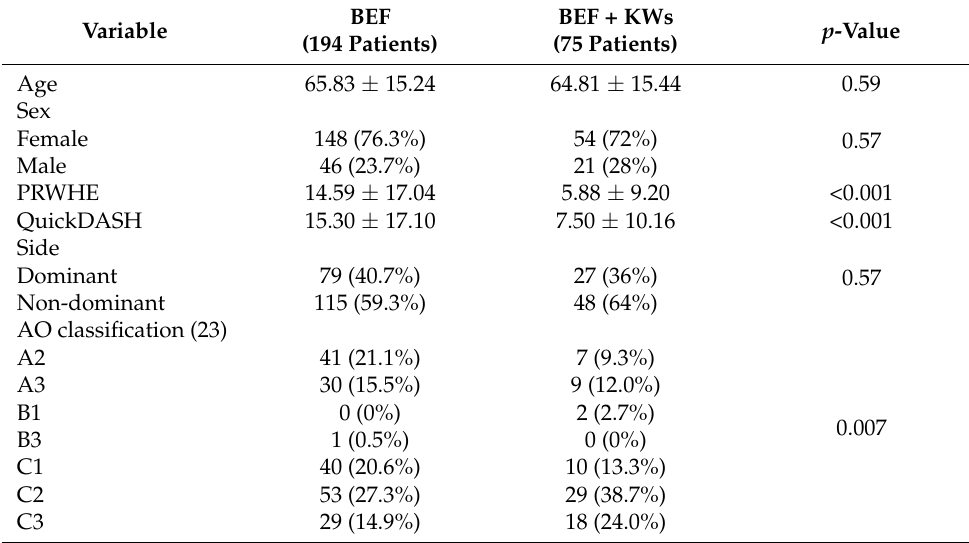
Table 2. Comparison between BEF and BEF + KWs